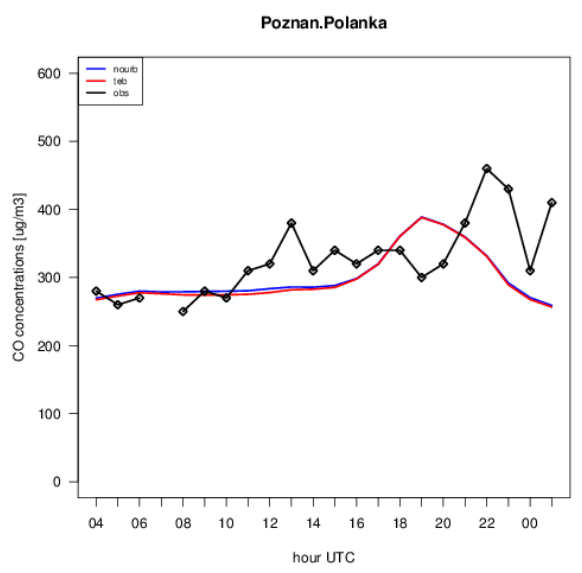
Fig. 10. Comparison of modelled NO 2 concentrations with obser- Figure 10 Comparison of modelled NO vations from station Poznan-Polanka for 3 January 2011 (red line - urban scenario, blue line - non-urban scenario, blak line - observa- Poznan-Polanka for 3rd of January 2011 (red line – urban scenario, blue line = non-urban tions). scenario)